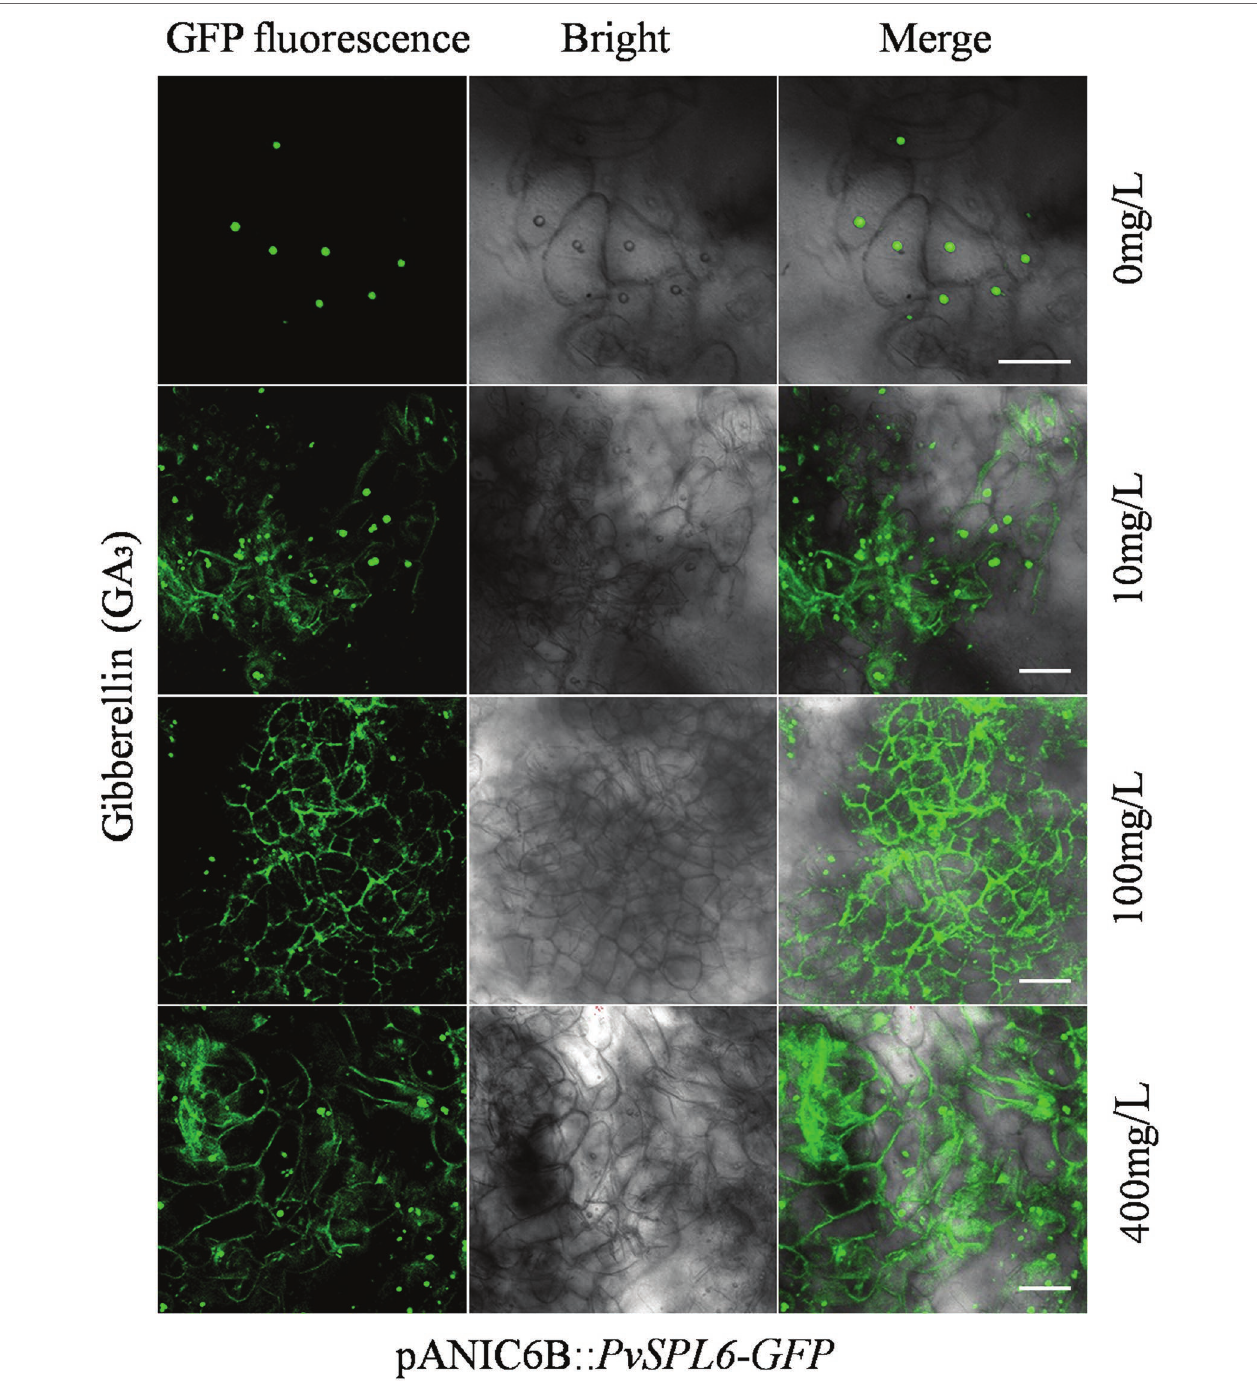
FIGURE 7 | Subcellular localization analysis of embryogenic callus from PvSPL6-GFP OE transgenic plants in response to GA 3 . Subcellular localization of PvSPL6 in response to different concentrations of GA 3 (0, 10, 100, and 400 mg/L). GFP fluorescence, green fluorescent signal; Bright, bright field signal; and Merge, superimposed signal. Scale bar = 20 μ